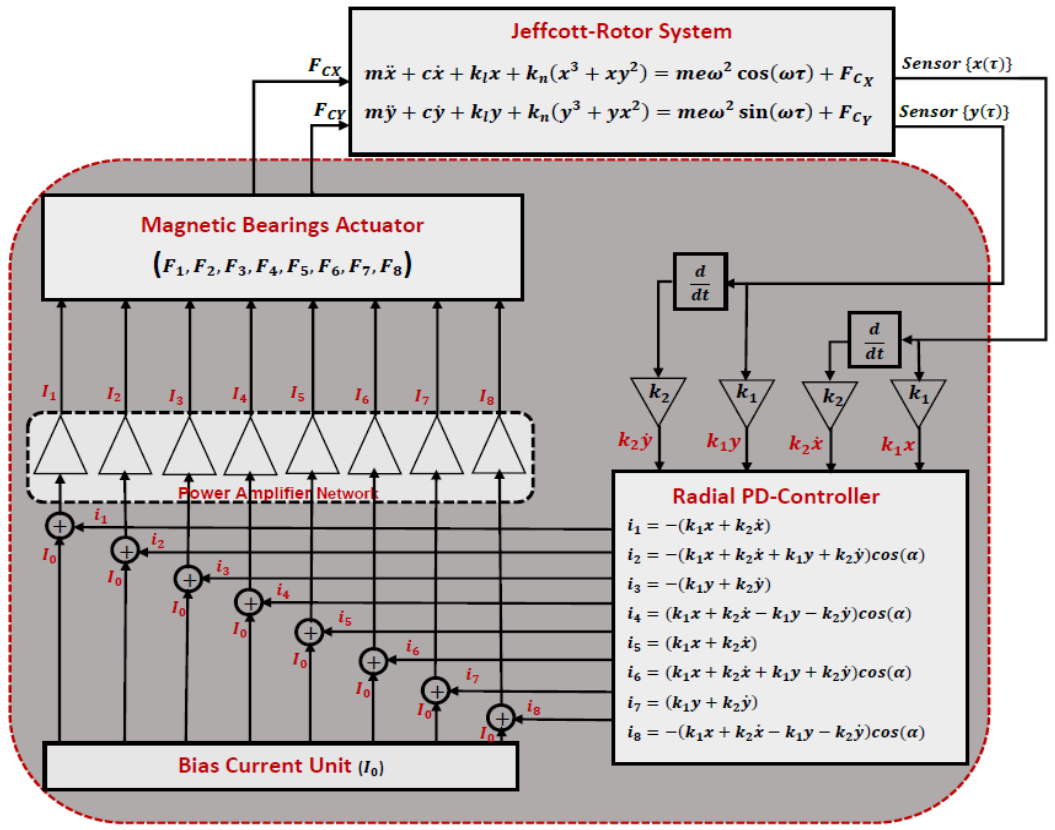
Figure 3. Schematic diagram to show the interconnection between the Jeffcott-rotor system, magnetic bearings actuator, and control algorithm.